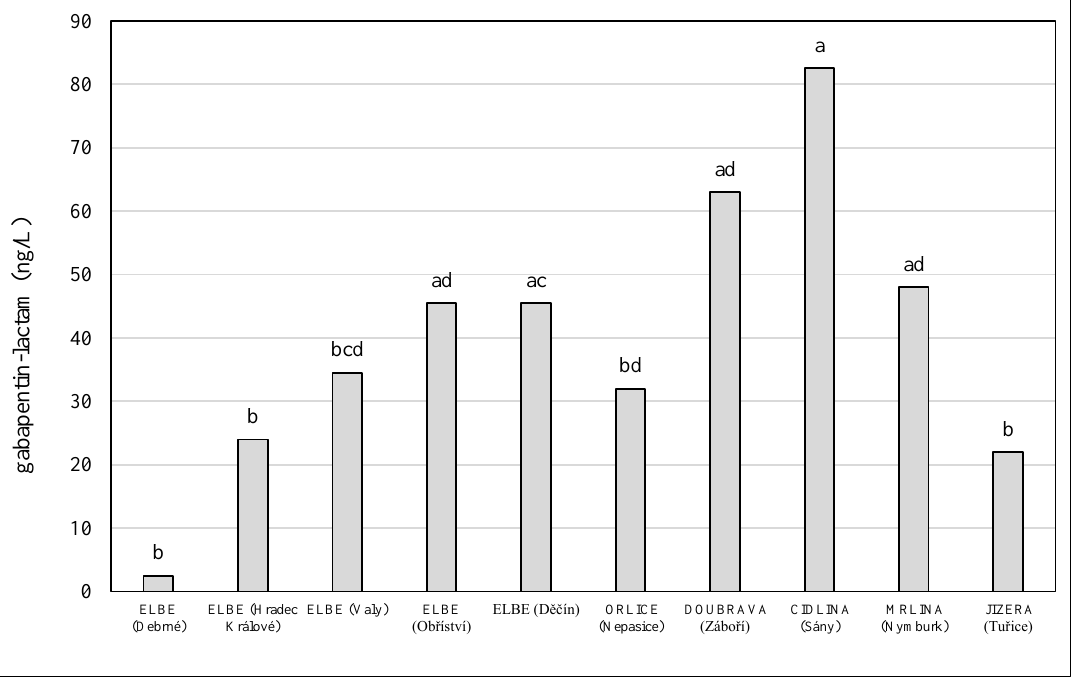
Figure 9. Median values of gabapentin-lactam concentration at the sampled locations during the year 2021. Significant differences among the localities are indicated by different alphabetical superscripts ( p < 0.05).